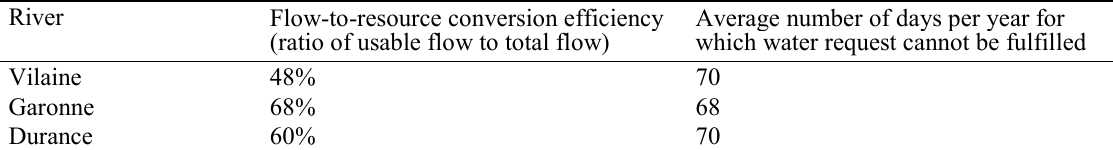
Table 2 Flow-to-resource conversion efficiency simulated for the three French rivers under the following hypotheses: no reservoir storage, in-stream reserved flow equal to 10% of the module, constant (urban) demand equal to the flow module year round.